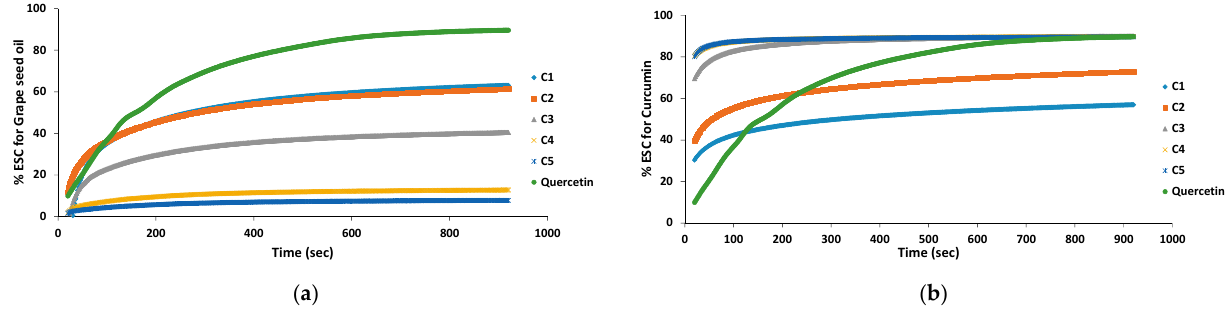
Figure 6. Variation of the % ESC for individual components Grape seed oil ( a ) and for curcumin ( b ) at various concentrations equivalent to concentrations at the selected grape seed oil-curcumin mixtures investigated for synergistic effect, at different ratio ( v / v ): C1 corresponds to 10:1 ( v / v ) ratio; C2 corresponds to 4.5:10 ( v / v ) ratio; C3 corresponds to 1:1 ( v / v ) ratio; C4 corresponds to 1:5 ( v / v ) ratio; C5 corresponds to 1:10 ( v / v ) ratio.